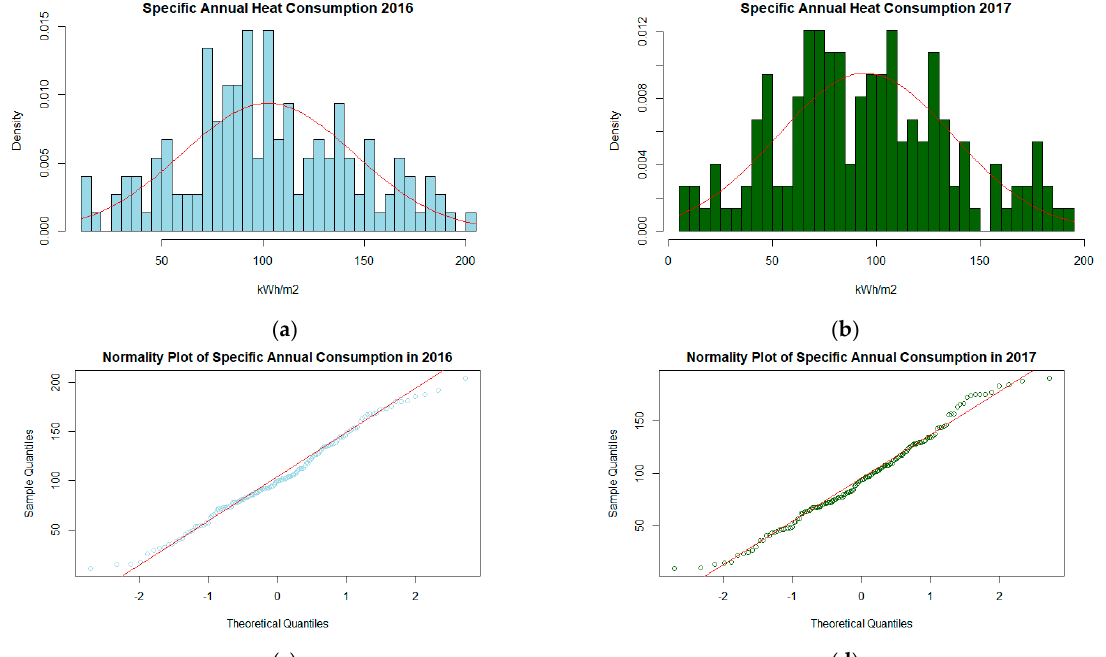
Figure 3. Box plot and normality plot visualisation of the specific annual heat consumption for 150 apartments with installed HCA: ( a ) Box plot for 2016; ( b ) Box plot for 2017; ( c ) Normality plot for 2016; ( d ) Normality plot for 2017.